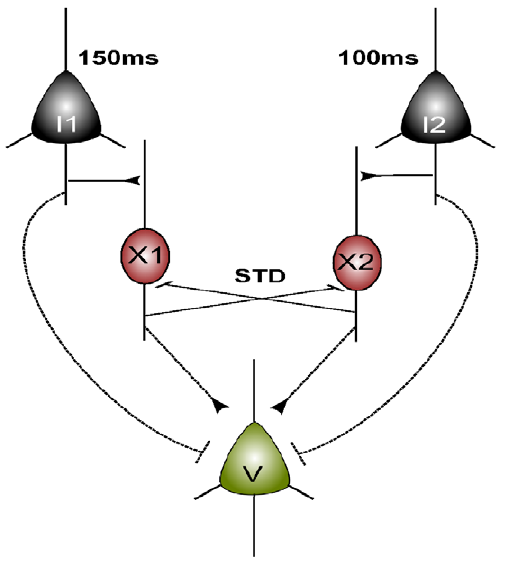
Figure 7. Scheme of the Simple Short Term Depression model. A schematic diagram of two mutually inhibitory neurons with short term depression X 1 and X 2 . I 1 and I 2 are input neurons which receive periodic input pulses. Neuron V is a virtual neuron which facilitates the readout of neurons X 1 and X 2 and is not suggested to be biological realistic as